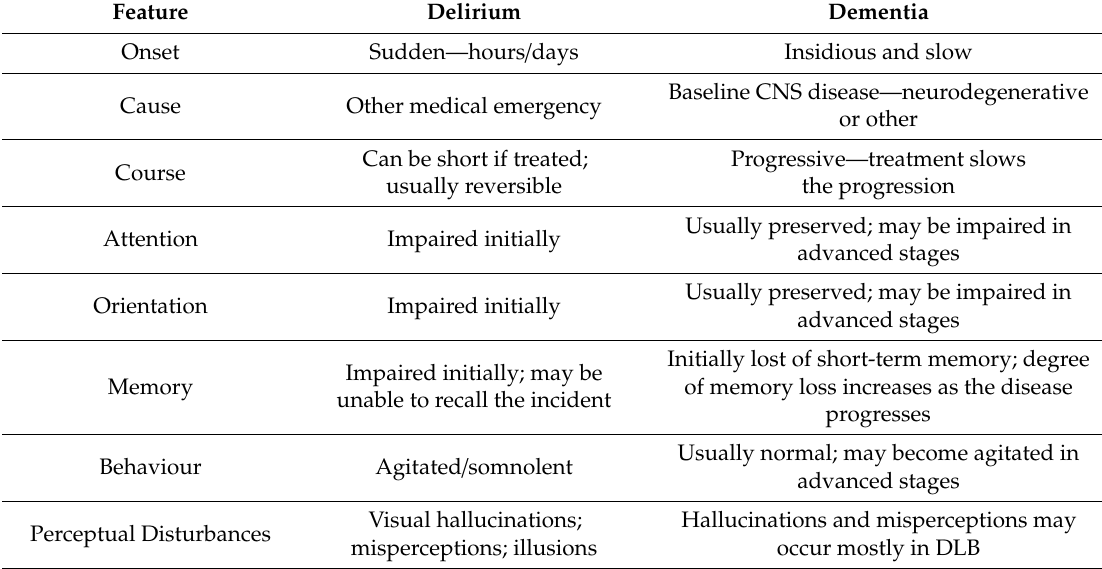
Table 2. Comparison of delirium and dementia